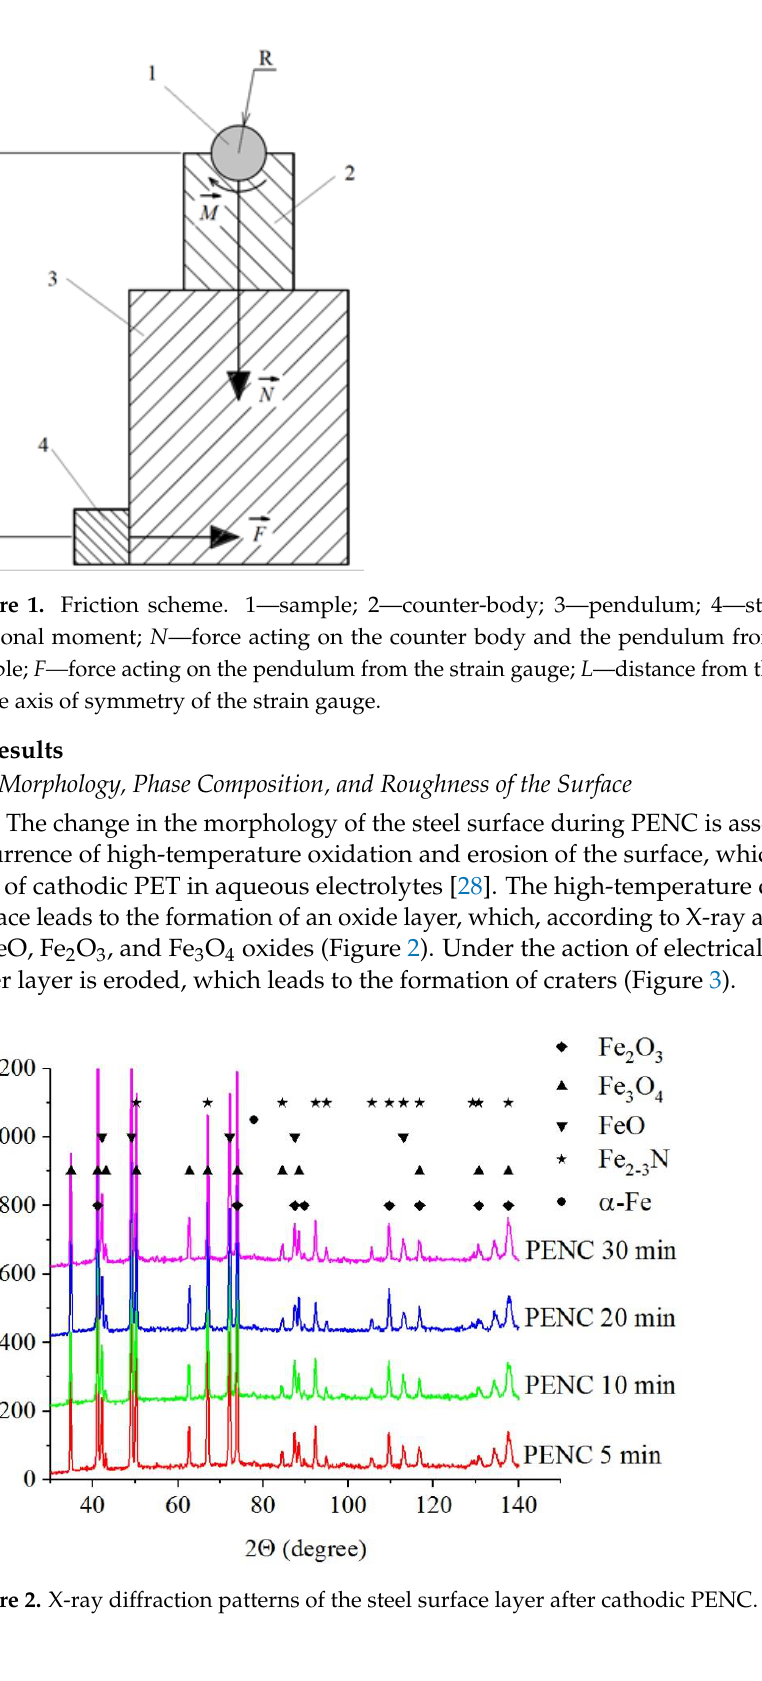
Figure 3. Morphology of the steel surface after cathodic PENC. With an increase in the duration of treatment, a linear increase in the weight loss of samples under the destructive action of discharges is observed, the surface roughness increases after 5 min and then decreases to 1.5 times after 30 min of treatment (Table 1).